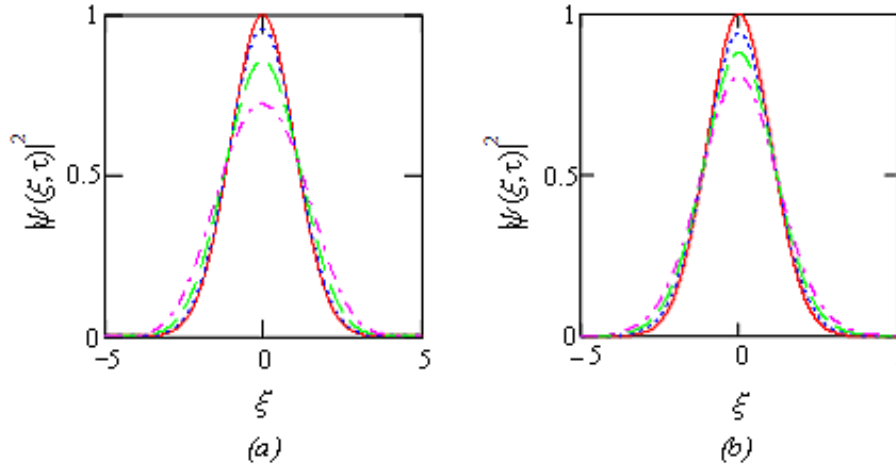
+ ψ 2 of the vector solution 1 2